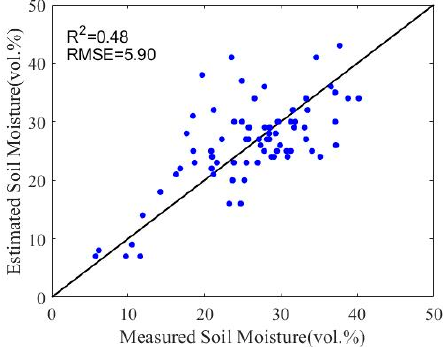
Figure 6. Scatterplots between the measured and predicted SMC values on the validation set based on RVI (Ratio method).